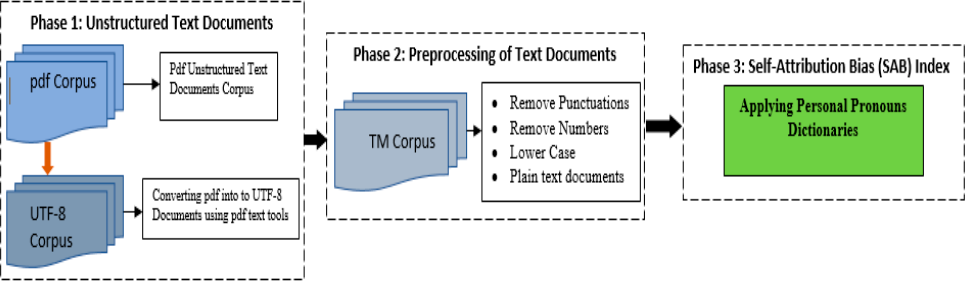
Figure 1. Construction of self-attribution bias (SAB) Indices using Natural Language Processing (NLP).